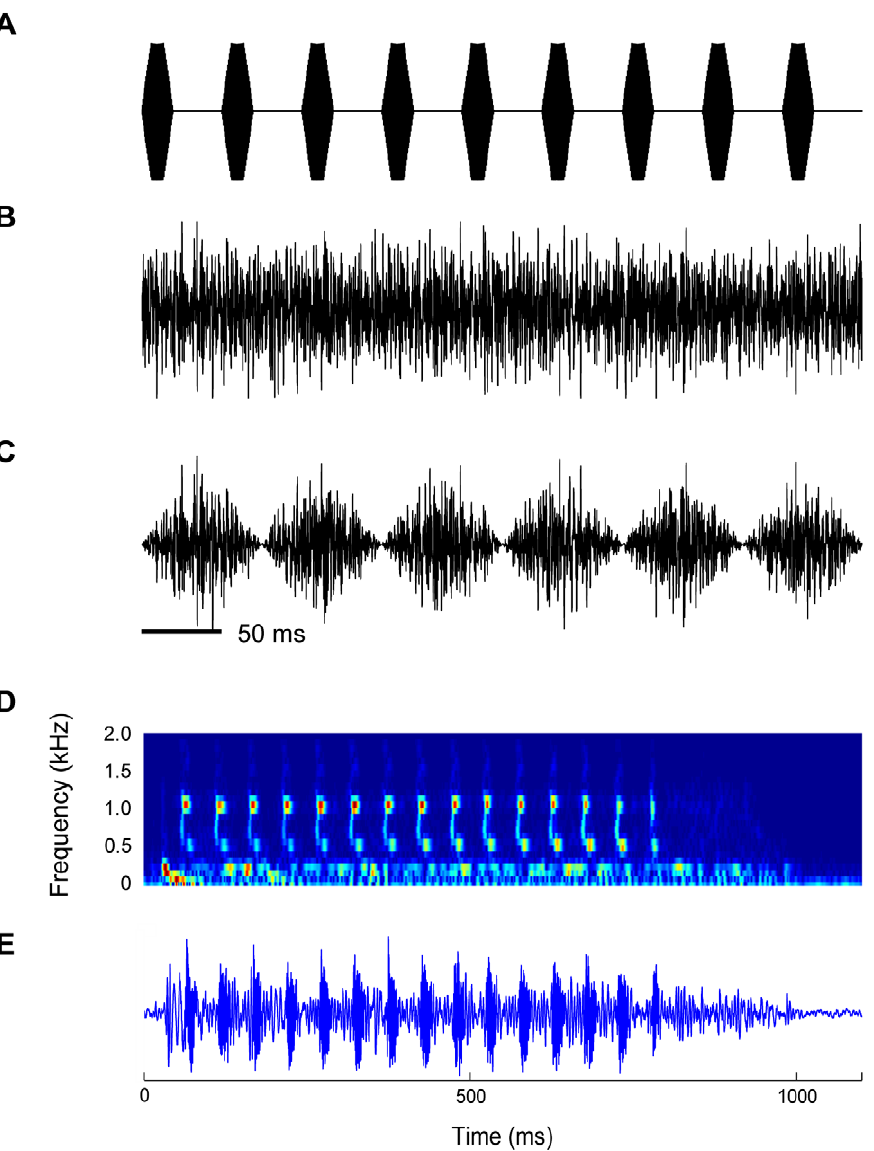
Figure 1. Acoustic stimuli employed in the experiments. A: The probe (P) was a PAM tone at 20 pulses/s with the carrier at the neuron’s CF. The maskers are noises with different bandwidths centered around the neuron’s CF (wideband noise shown); these were either unmodulated (M u , B ) or amplitude modulated (M m , C ) with a modulation depth of 100%. The rise- and fall times for M u were 5 ms. Spectrogram ( D ) and waveform ( E ) of the Rana pipiens advertisement